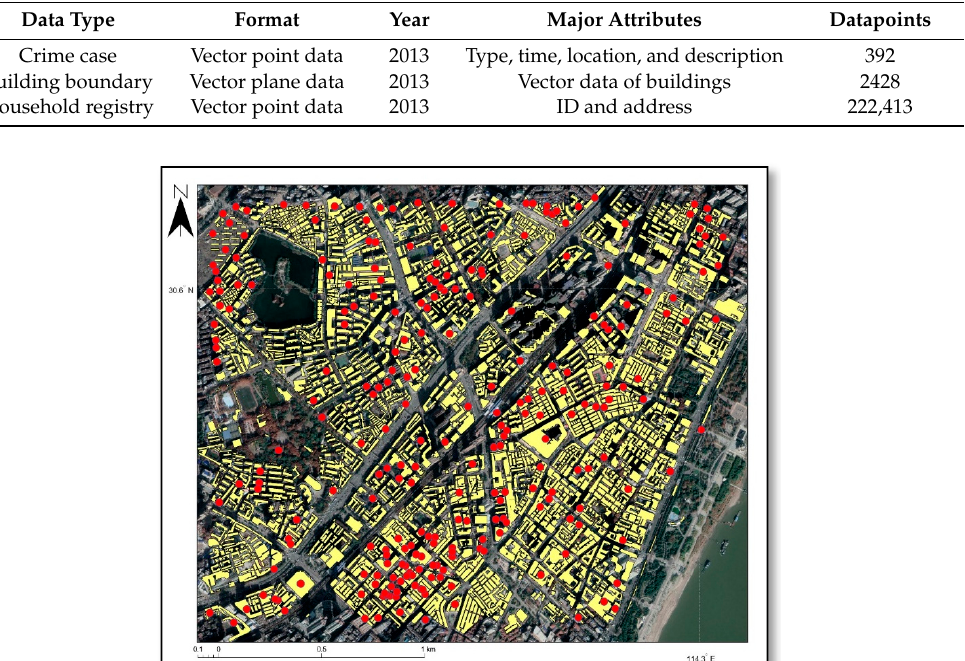
Figure 2. Building boundary (spatial constraints) and burglary distribution considered in this study.